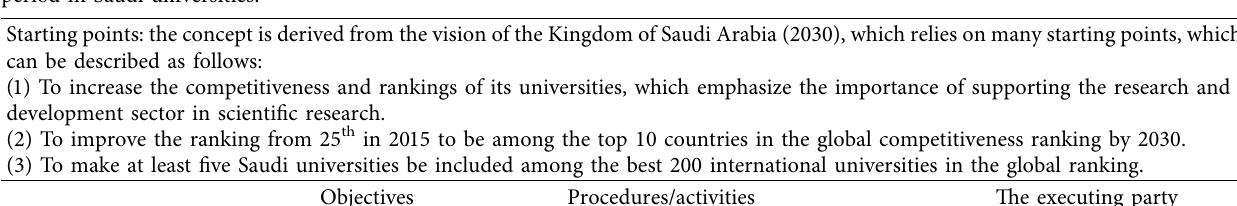
Table 8: The proposed vision to anticipate the future of scientific research in the area of educational sciences during the postpandemic period in Saudi